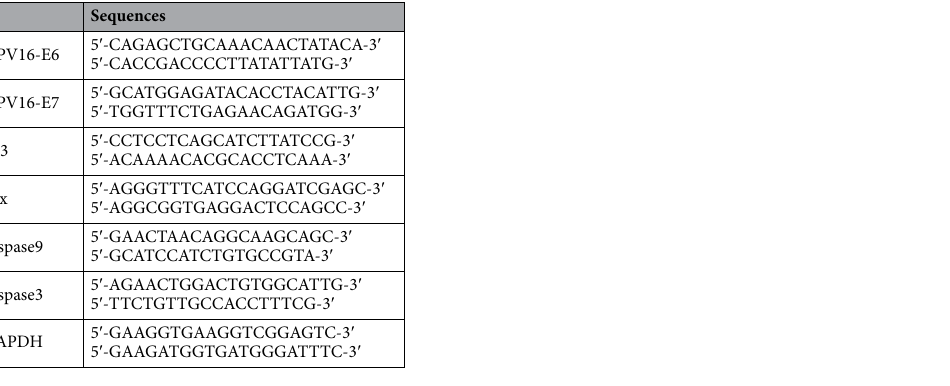
Table 2. The sequences of RT-PCR